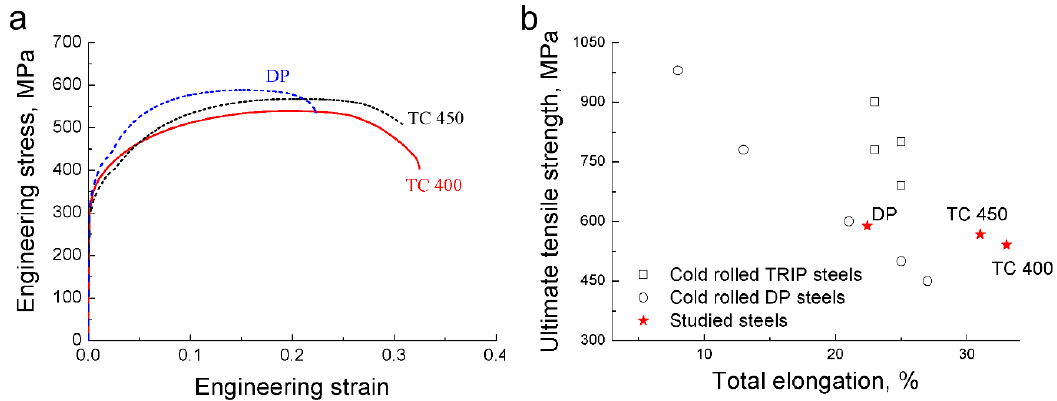
Figure 12. ( a ) Engineering stress-engineering strain curves and ( b ) comparison of mechanical properties for the studied steels and DP and TRIP steels conventionally cold/hot rolled in the steel industry [37].